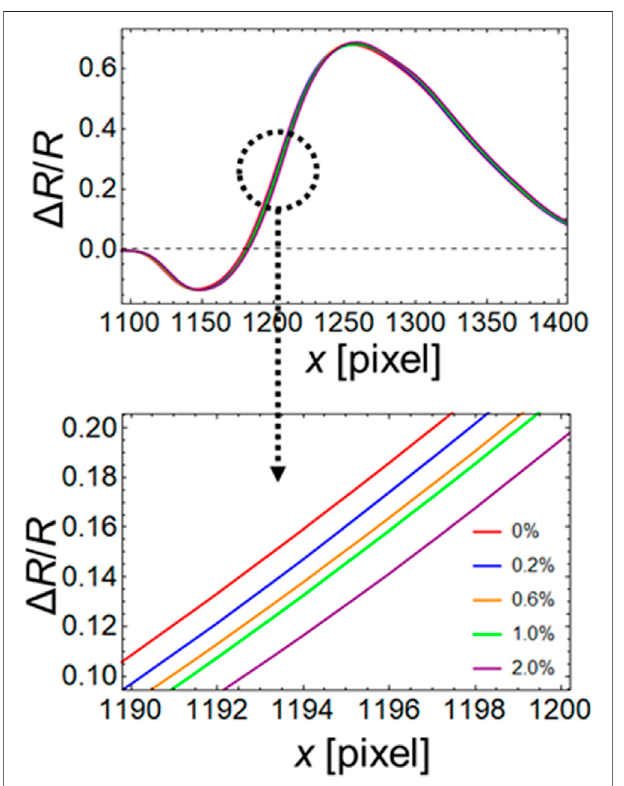
FIGURE 9 | Δ R / R for ethanol gas concentrations of 0 – 2.0 vol.% as a function of the pixel position along the horizontal direction.